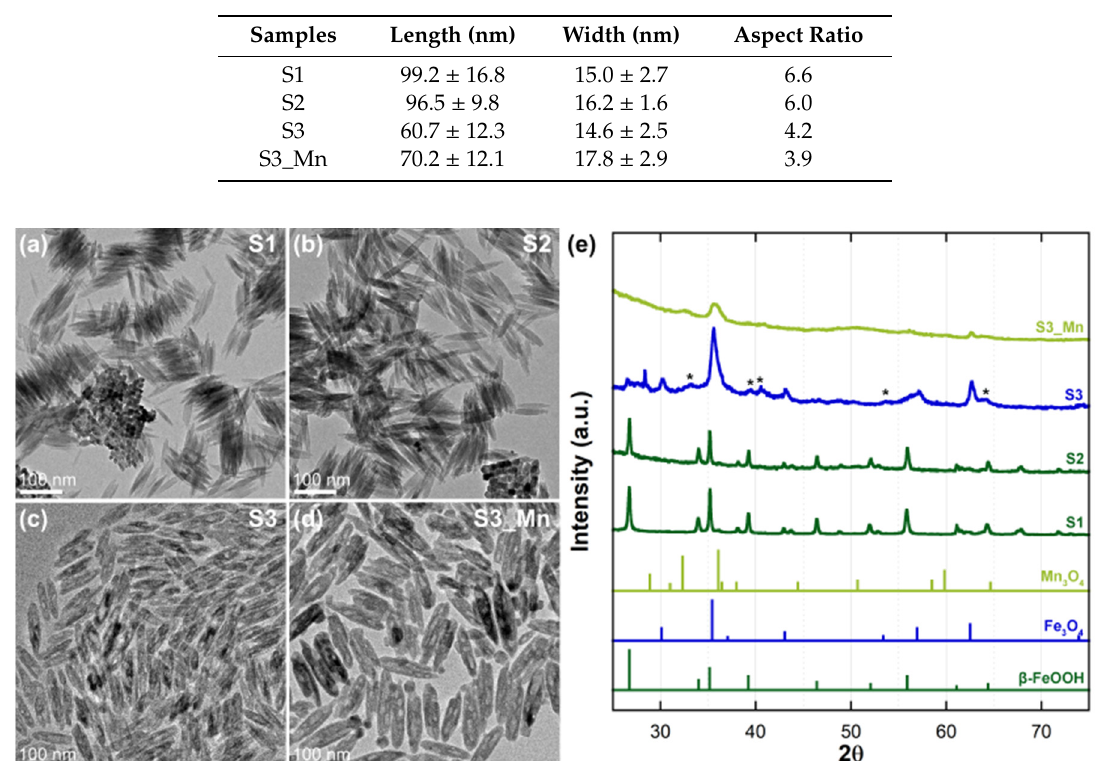
Figure 1. Conventional TEM imaging of the samples: ( a ) S1; ( b ) S2; ( c ) S3; ( d ) S3_Mn. Panel ( e ) reports the XRD pattern of all samples. The * symbol in the S3 sample’s XRD pattern indicates the peaks coming from hematite residuals.